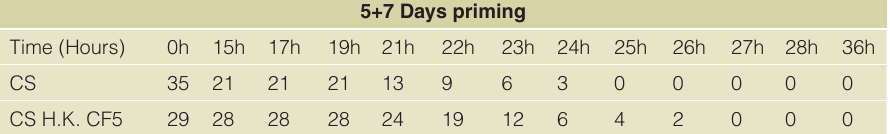
Table S7. Survival kinetics of wt flies 5 and 7 days post priming with heat-killed Pseudomonas aeruginosa CF5. Canton S (CS) wild type flies were primed twice with heat-killed (H. K.) CF5 cells at days 5 and 7 prior to injection with PA14. Naive (n=35) and primed (n=29) flies were inoculated with the virulent PA14 strain 7 days post priming. Top row numbers indicate the time in hours post challenge whereas lower rows indicate the corresponding number of surviving flies in naive and primed flies respectively. Sample size is indicated at